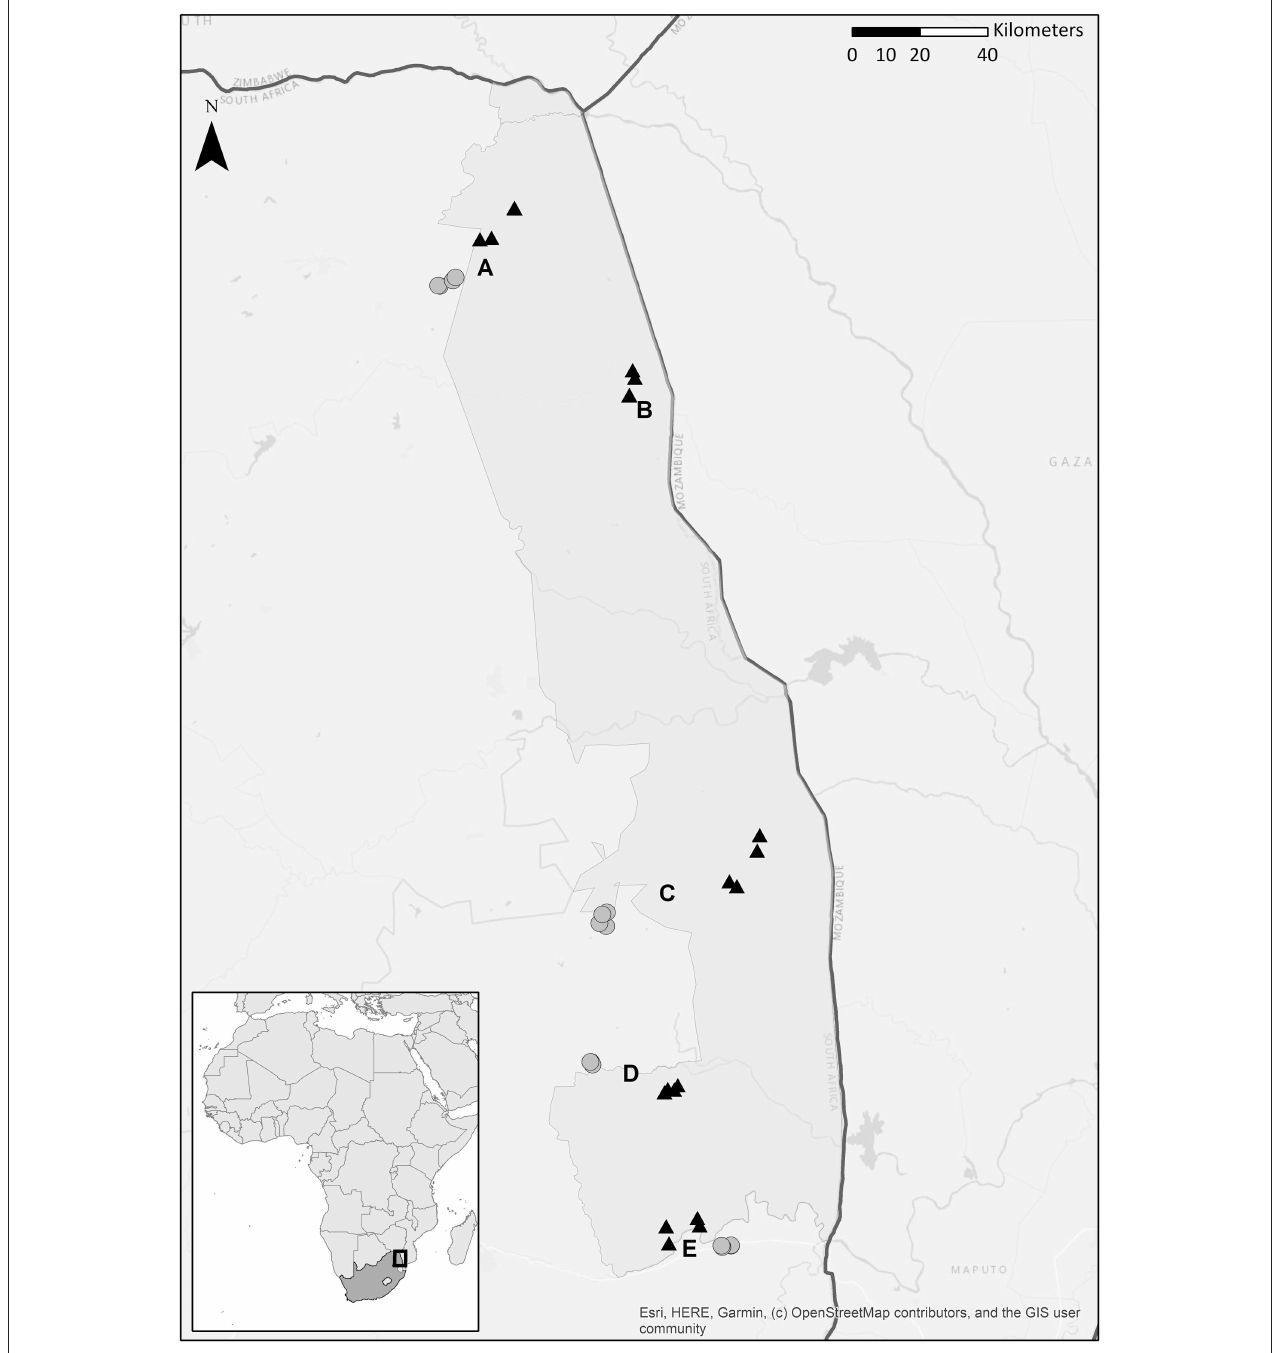
FIGURE 1 | Map depicting four paired locations [Punda Maria (A) , Malelane (C) , Skukuza (D) , and Satara (E) ] and a single unpaired location [Shingwedzi (B) ], each location has three or four stagnant water bodies. Five locations were situated inside Kruger National Park, South Africa (natural area, depicted with a black triangle); four were situated in the fringing rural communities (rural communities, depicted with a gray dot). See Table S1 for the coordinates. Courtesy of Maarten van ’t Zelfde. impacted the following steps. We considered dilution of the to remove remaining humic acids and other PCR-inhibitors. sample undesirable (this would negatively impact the detection For the PCI protocol, the stored PES-filters containing the probability of less abundant species), and therefore used the eDNA were incubated for 10 min at 65 ◦ C. After this, 900 µ L phenol-chloroform-isoamylalcohol (PCI, 25:24:1) was added OneStep-96 TM PCR inhibitor removal kit (Zymo Research)